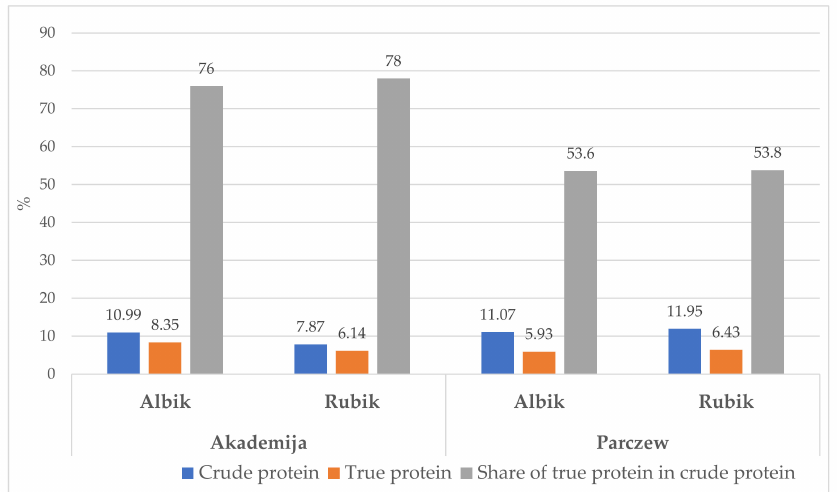
Figure 6. The content of crude and proper protein and the share of proper protein in crude protein, depending on the cultivars H. tuberosus and geographical